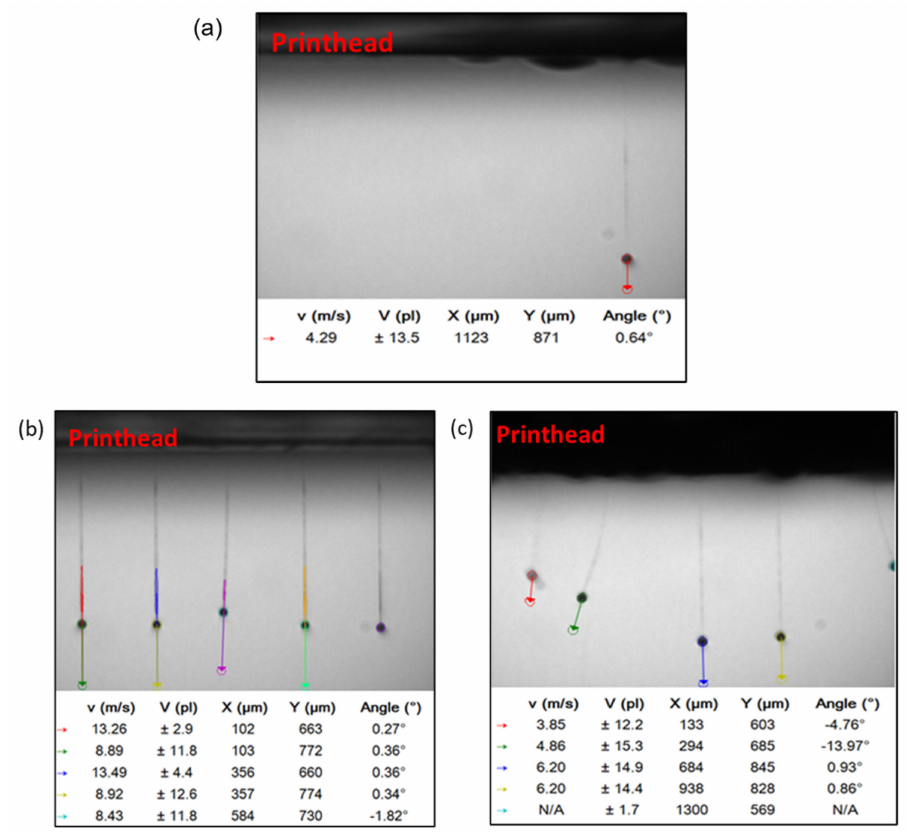
Figure 9. ( a ) Dynamic analysis of B-ink (1) droplets by drop-watcher of the PiXDRO LP50 printer showing clogged nozzles produced by using the waveform shown in Figure 7 ( c ). ( b ) Long tails of large droplets produced due to an increased printhead temperature of 40 ◦ C and ( c ) diverging droplets with random flight directions producing unwanted printed structures using an increased voltage of 60